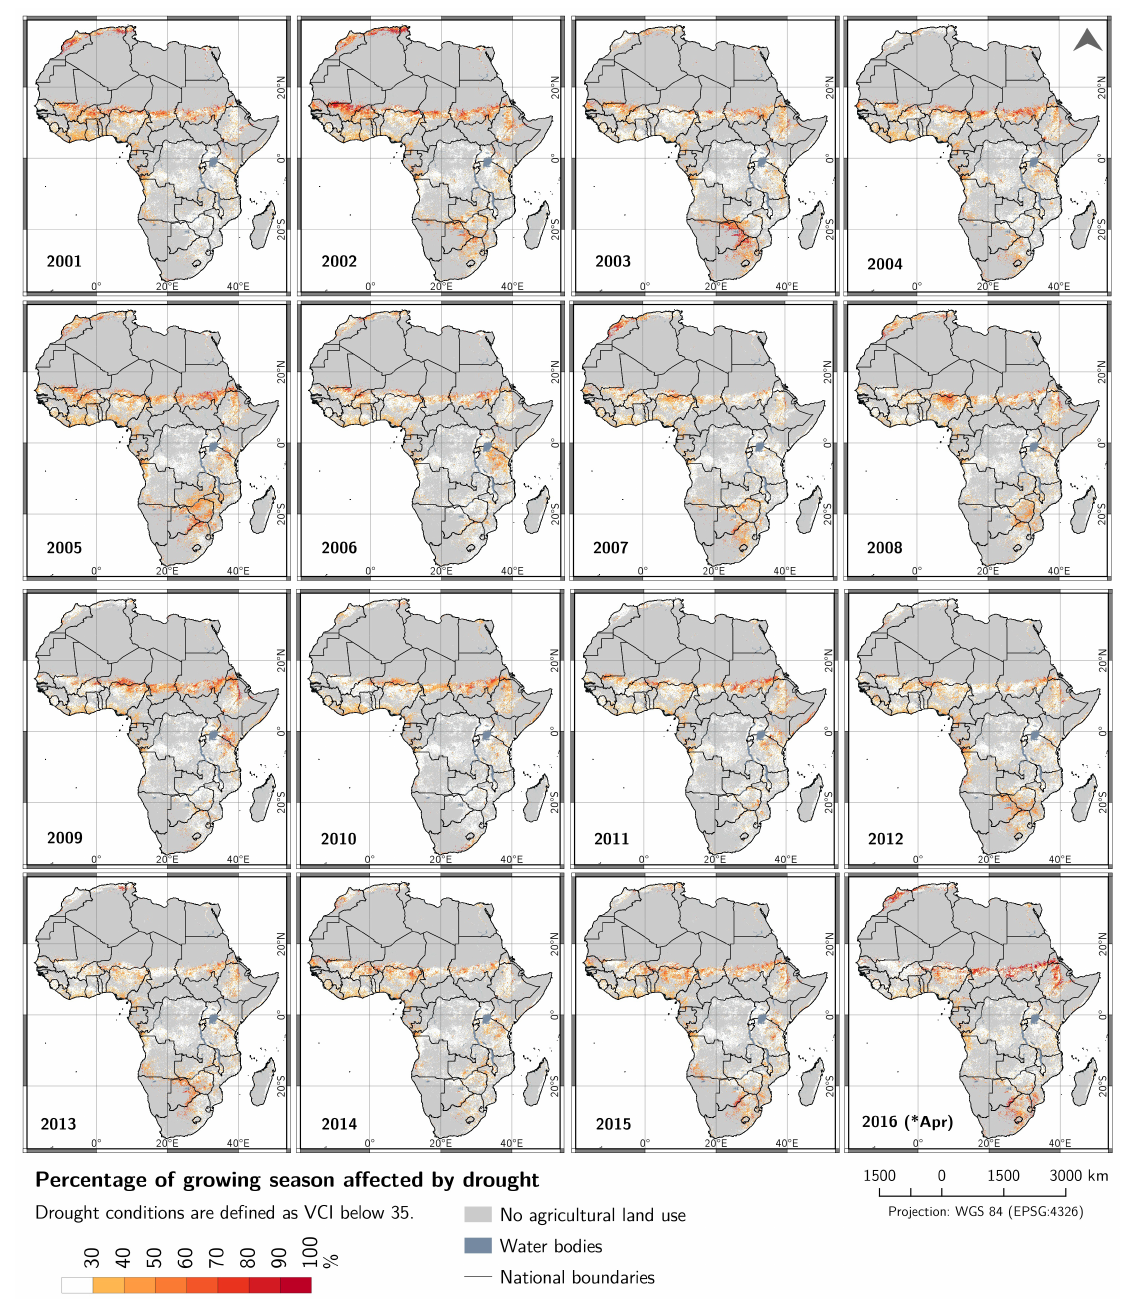
Figure 7. Relative duration of drought: Percentage of growing season affected by drought events (VCI below 35) from 2001 to 2016 (seasonal